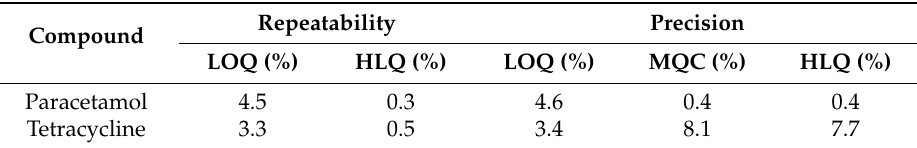
Table A3. Determined repeatability and intermediate precision values for paracetamol and tetracycline. HLQ: highest limit of quantification; MQC: medium quantified